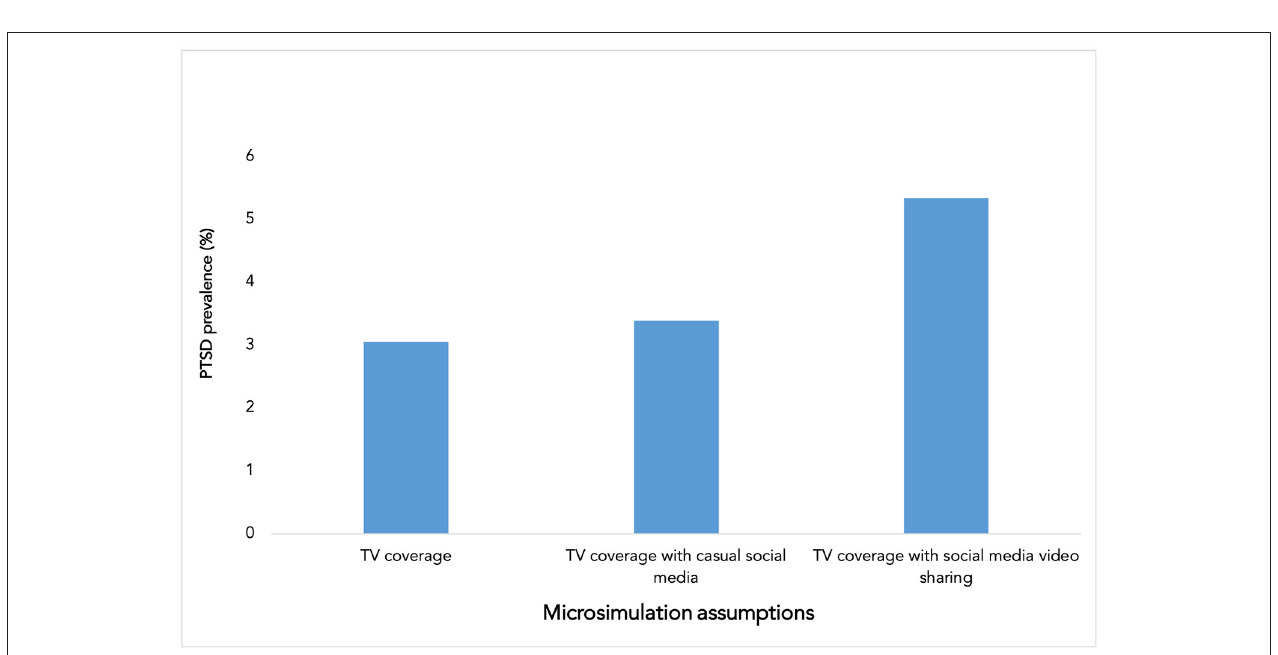
about the event. This echoes emerging evidence that exposure to social media relevant to traumatic events is associated with increased PTSD prevalence. For example, following the